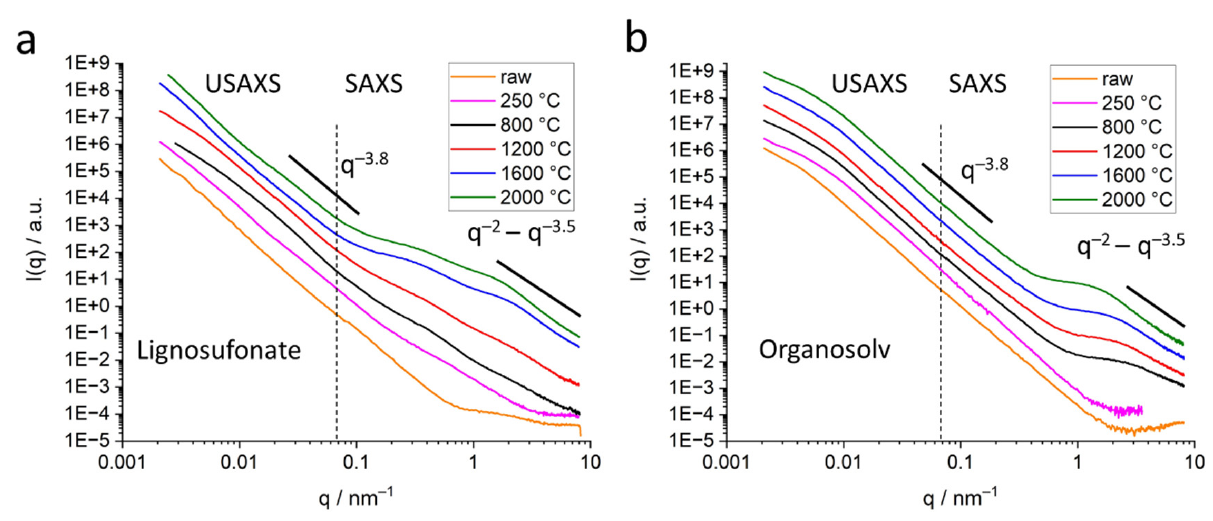
Figure 5. Small-angle X-ray scattering data of samples with different heat treatment—raw lignin, thermostabilized (250 ◦ C), 800 ◦ C, 1200 ◦ C, 1600 ◦ C and 2000 ◦ C. The heat treatment temperatures are indicated in the graph. The curves are shifted along the Y -axis to enhance visibility; the curves displayed at higher intensity correspond to higher heat treatment temperature. The panels display scattering curves of ( a ) lignosulfonate; ( b ) organosolv. The q ranges of USAXS and SAXS are indicated by the dashed line. The slopes of the power law in the scattering curves are indicated.